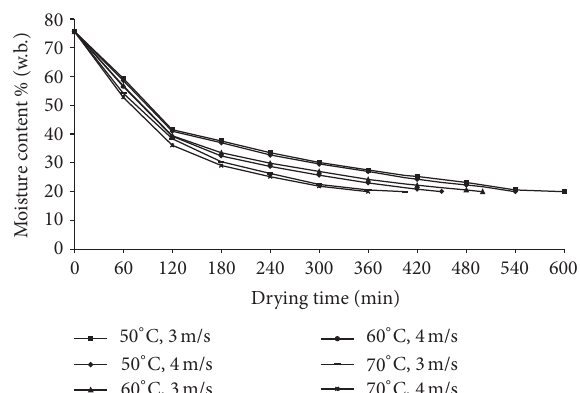
Figure 2: Air temperature and air velocity influence on green peas